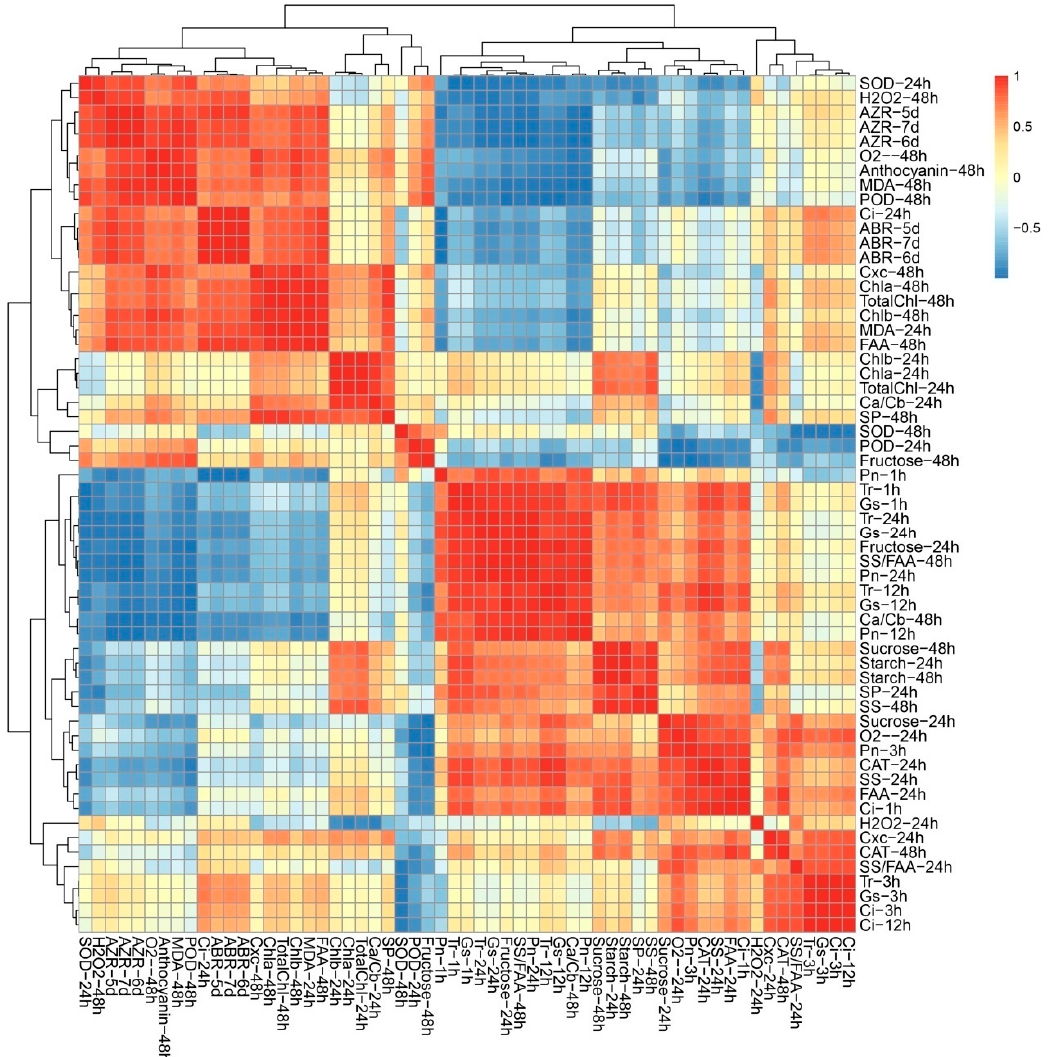
Figure 5. Correlation analyses among different indices in leaf.